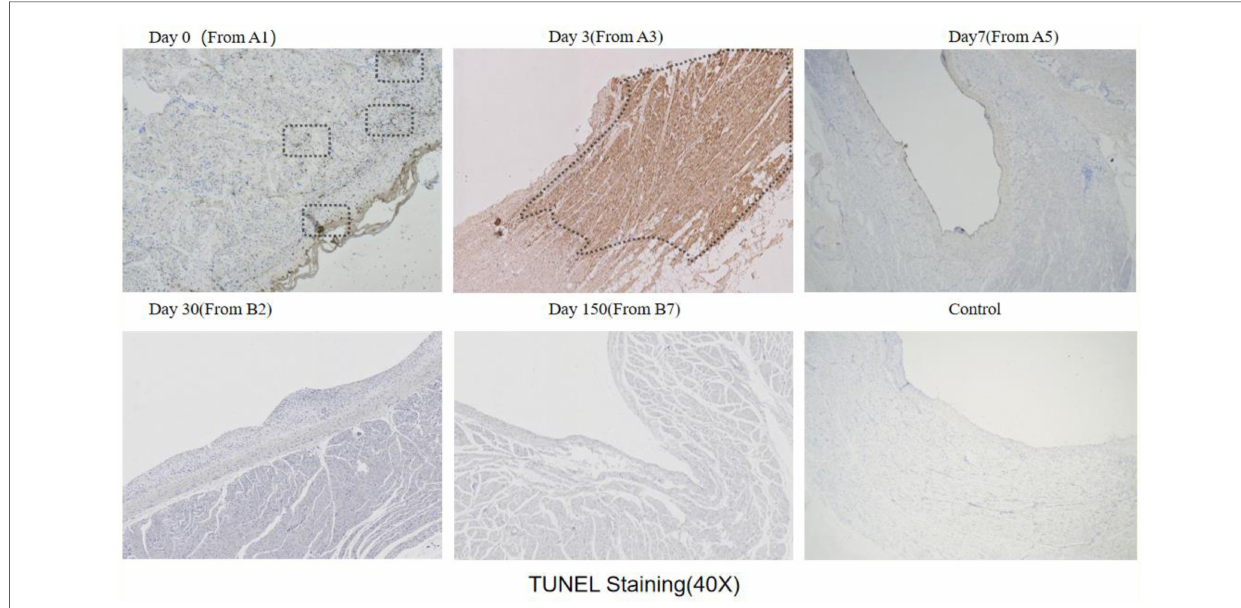
FIGURE 9 Tunel staining results (observed under 40x microscope): Tunel staining will darken apoptotic cells to brown or reddish brown, while ordinary cells will be blue or light; The black wireframe is dark apoptotic area, and Day3 and Day0 (a small amount) and Day3 have dark areas.